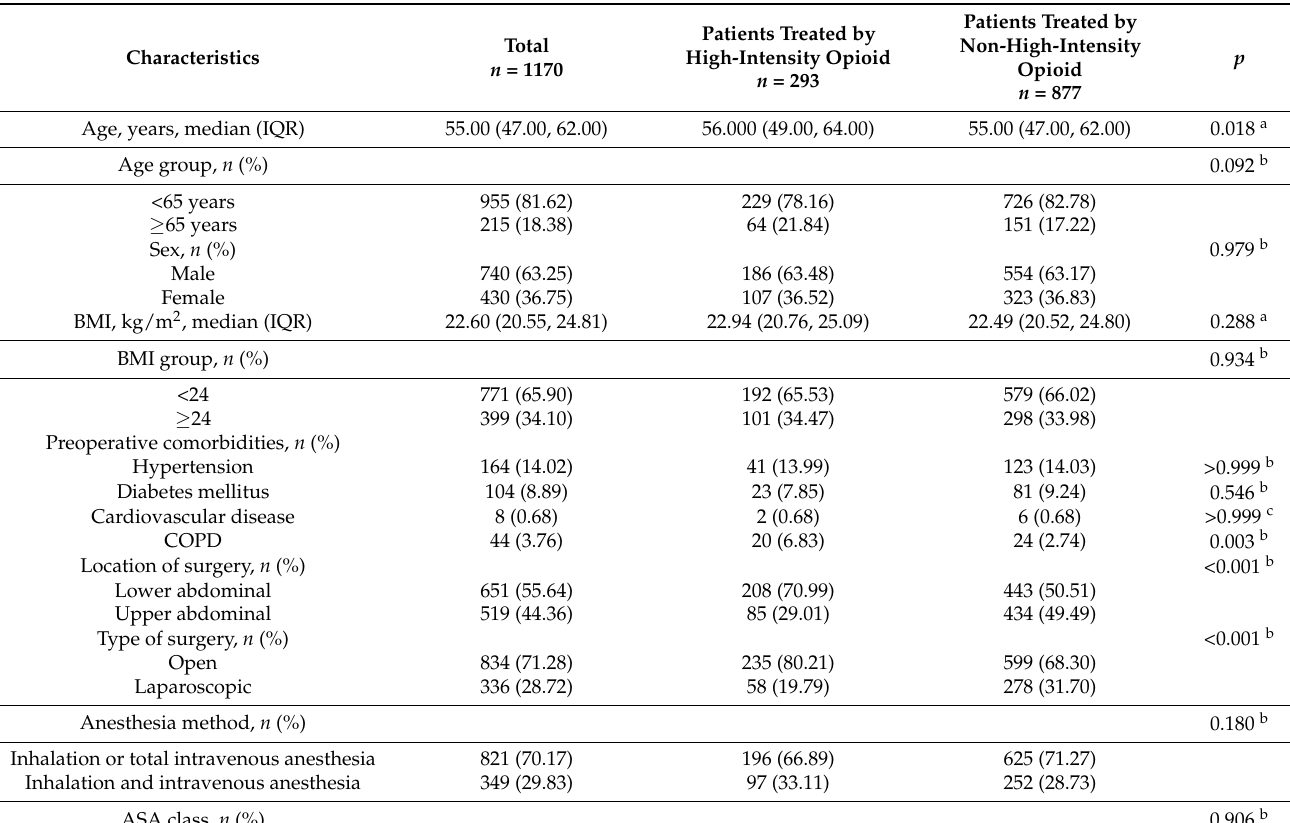
Table 1. Clinicodemographic and clinical characteristics of patients given opioids after abdominal surgery.